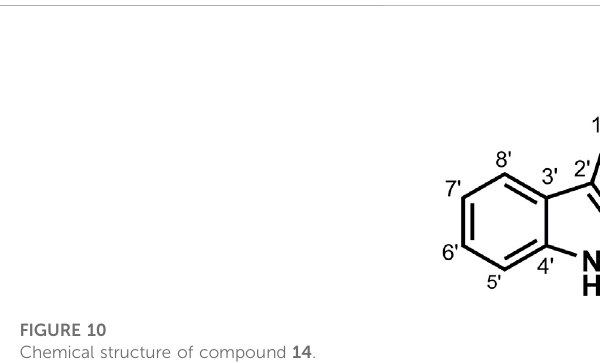
FIGURE 10 Chemical structure of compound 14 .